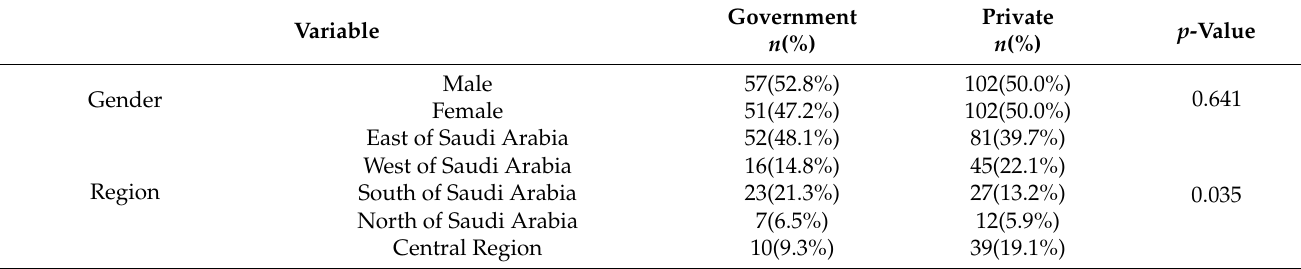
Table 5. Association of demographic profile and endodontic practices with respect to the